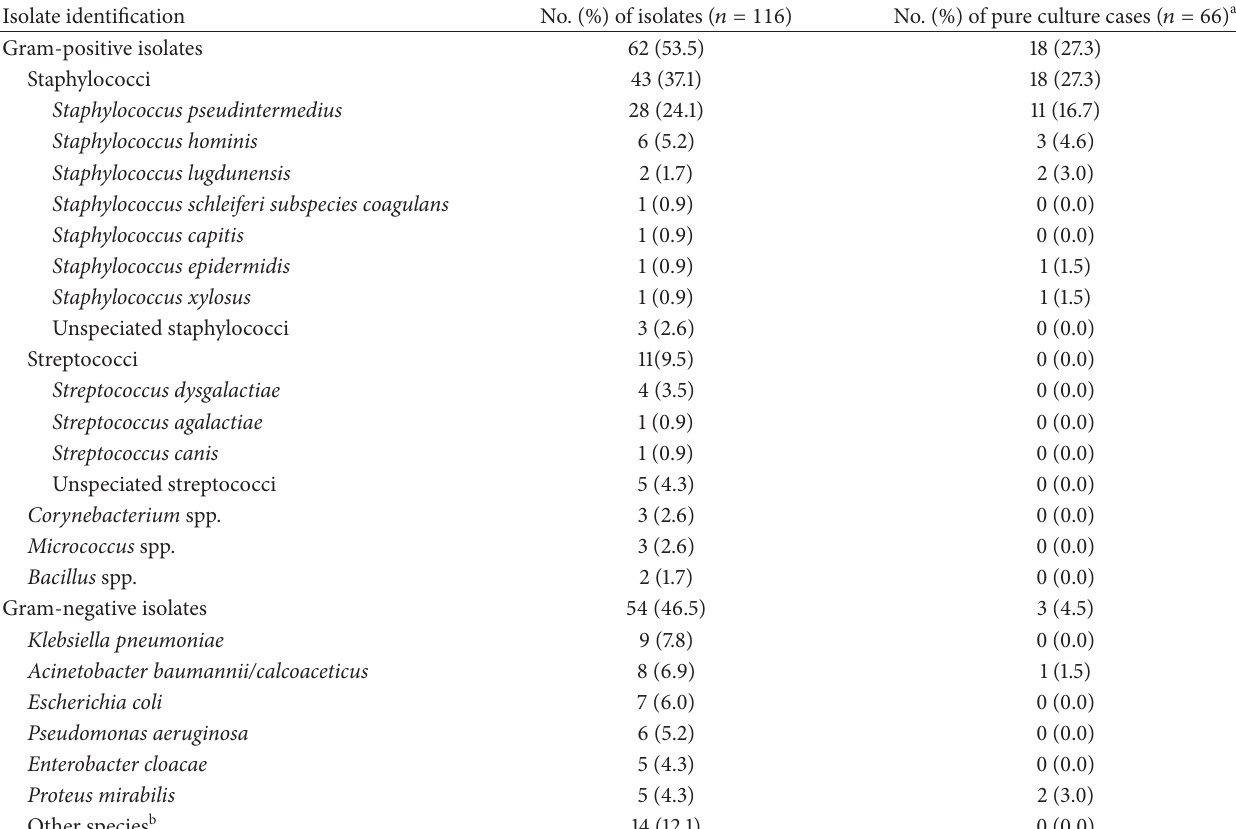
Table 1: Types and number of bacterial isolates from canine pyoderma cases in Grenada, West Indies. Isolate